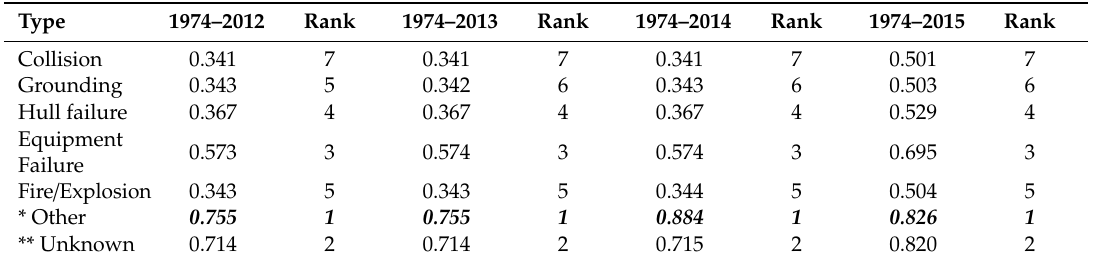
Table 4. Grey relational analysis and ranking of oil spills of less than 7